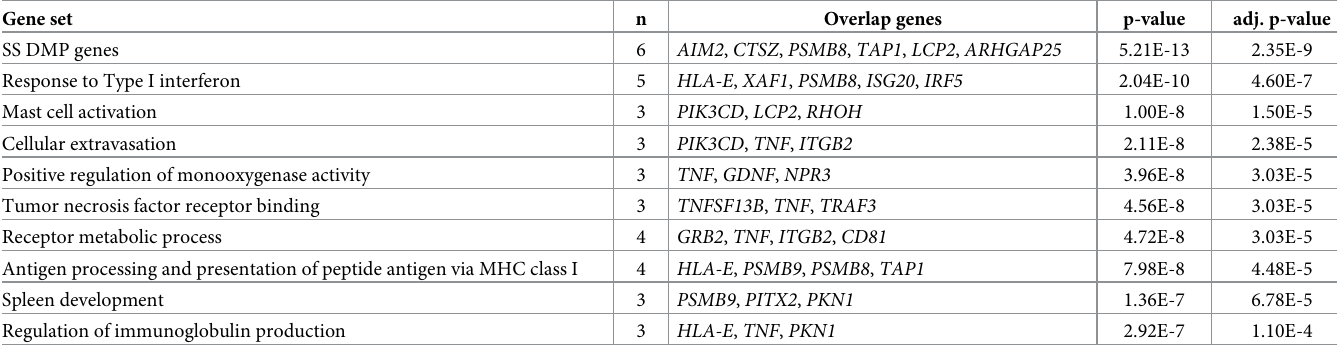
Fig 2. Clinical phenotype comparison between severe SS and mild SS. Plots of clinical phenotypes that are different at an α = 0.05 significance level between severe SS cases and mild SS cases. Severe SS cases are from clusters 1 and 2 and mild SS cases are from clusters 3 and 4. P-values from Wilcoxon rank sum tests or chi-square tests of independence are shown above each subplot. (A) Immunoglobulin G box plot. (B) Focus score box plot. (C) Ocular SICCA score (maximum of left and right eyes) box plot. (D) Detection of antinuclear antibody at 1:40 concentration level bar plot. (E) Anti- Ro/SSA bar plot. (F) Anti-La/SSB bar plot. (G) Rheumatoid factor bar plot. (H) Germinal center (GC)-like formation bar plot. https://doi.org/10.1371/journal.pone.0281891.g002 Table 3. Top gene sets enriched for hypomethylated